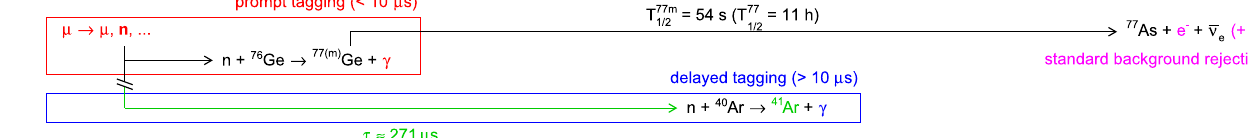
after receiving either a prompt or delayed tagging signal. The accom- panying γ ’s in the subsequent decay are essential in the suppression by standard background rejection techniques based on prompt coinci-